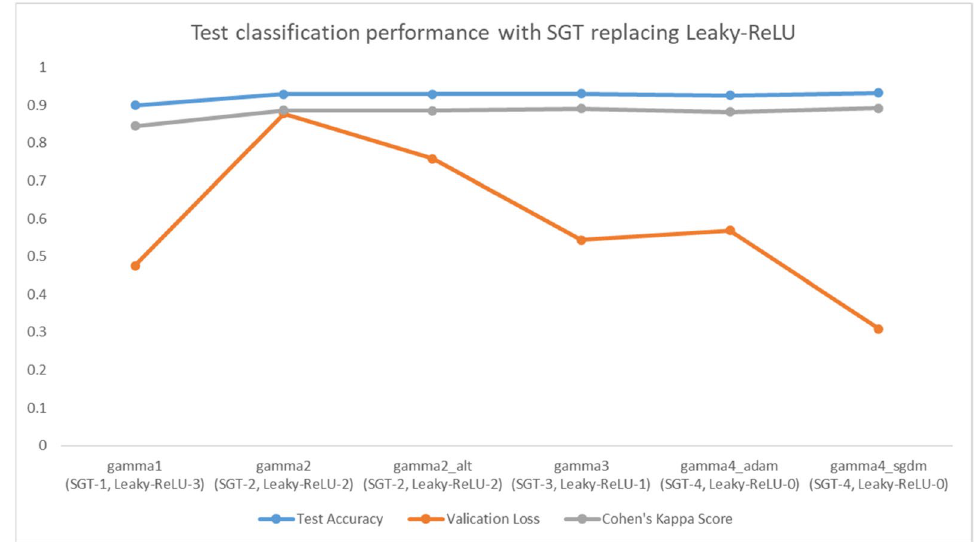
Figure 5. Controlled experiment result with proposed SGT layer gradually replacing Leaky-ReLU layer. Here gamma_X represents the SGT layer where X is the number of SGT layer. In total, we had 4 activation layer replaced in the final experiment. The result keeps on improving with increasing number of SGT layers.